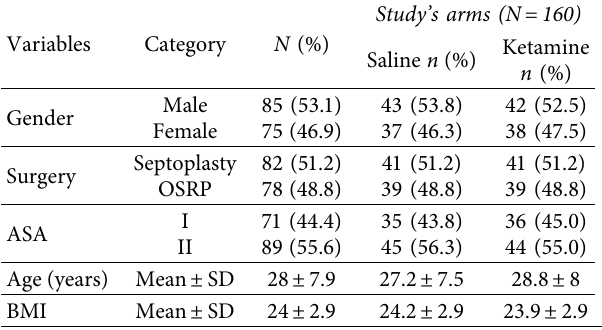
Table 1: Demographical and clinical data of the sample.